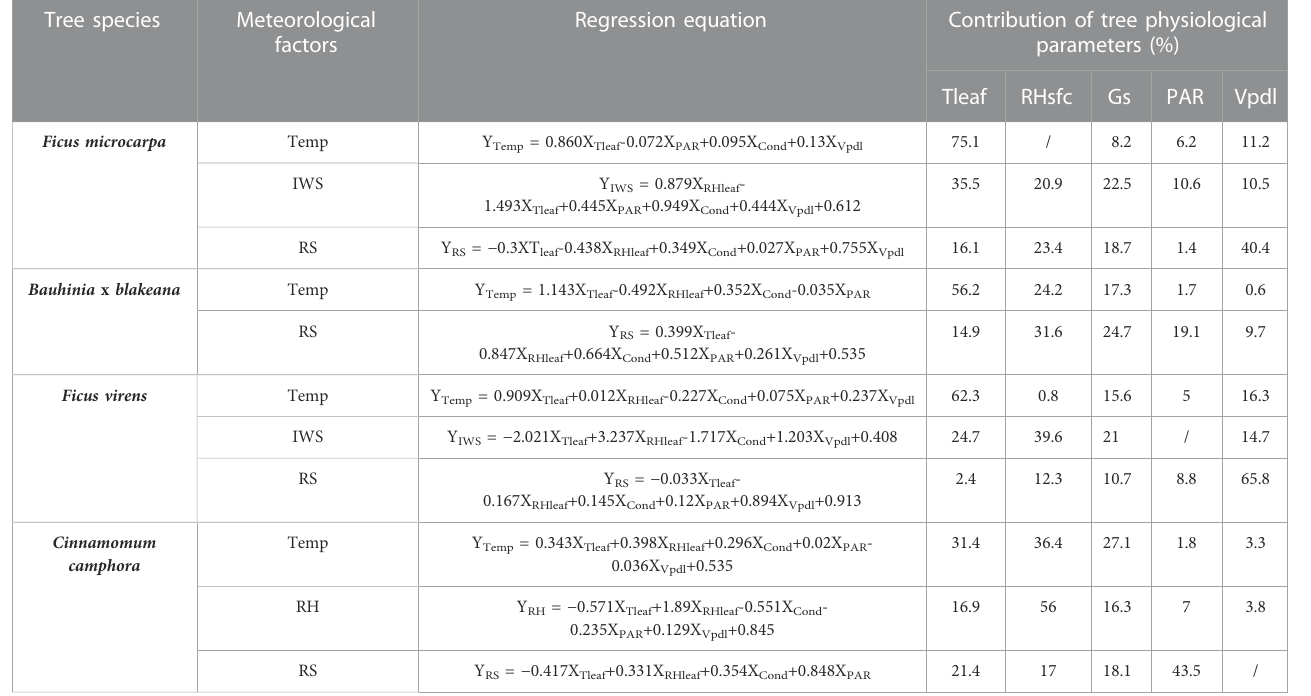
TABLE 6 Regression equation and contribution of physiological parameters of trees. Tree species Meteorological Regression factors